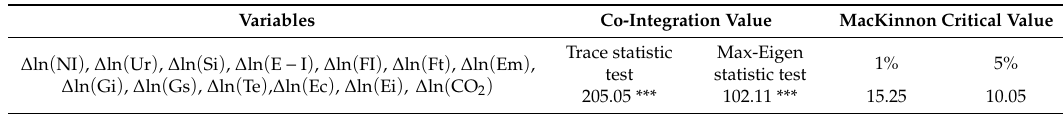
Table 2. Co-integration test by Johansen and Juselius.